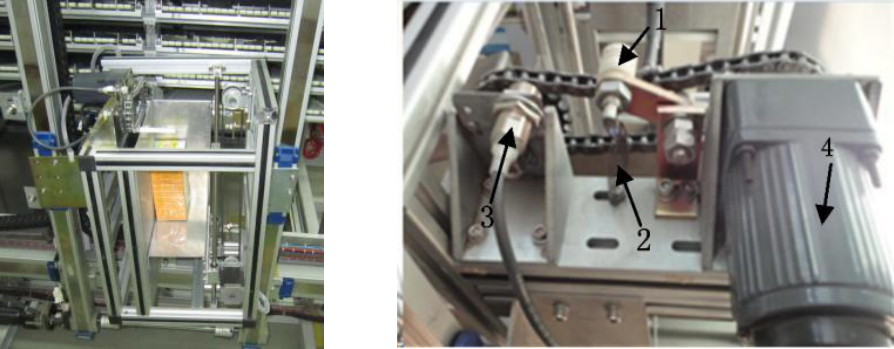
Figure 7. End actuator. 1.Chain clamping device. 2. Flexible tensioning device. 3. Detection sensor. 4.